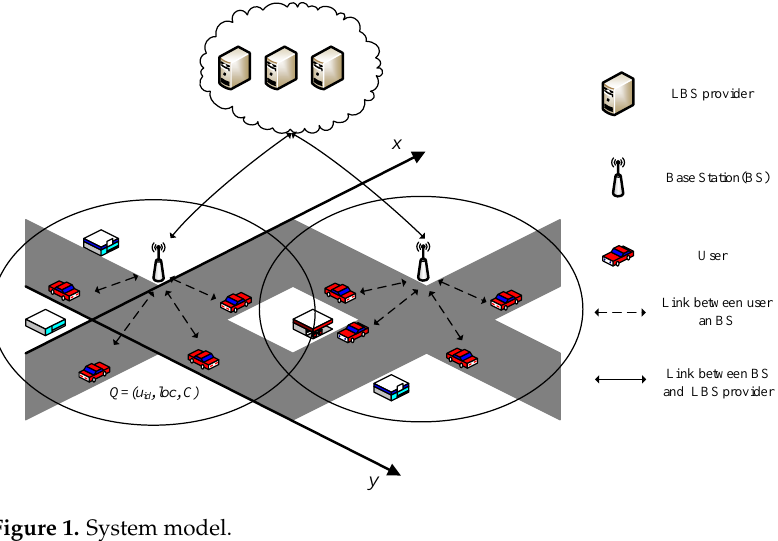
Figure 1. System